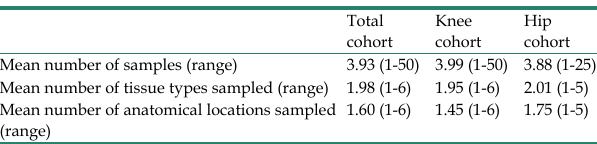
Total Knee Hip cohort cohort cohort